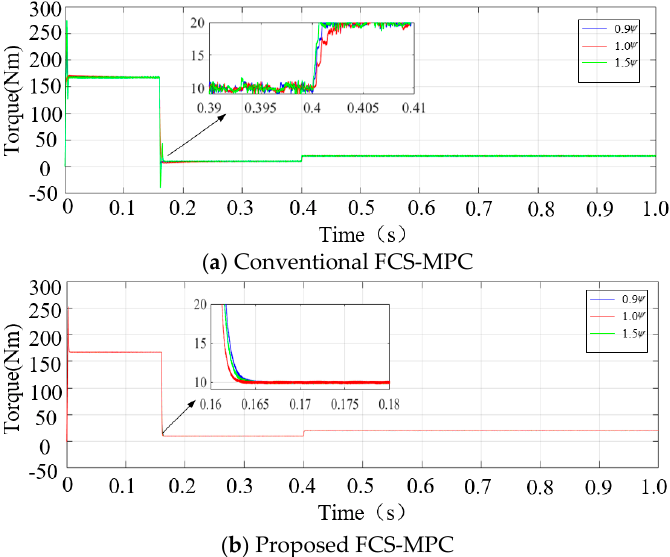
Figure 9. Torque ripple simulation when the flux is changed.